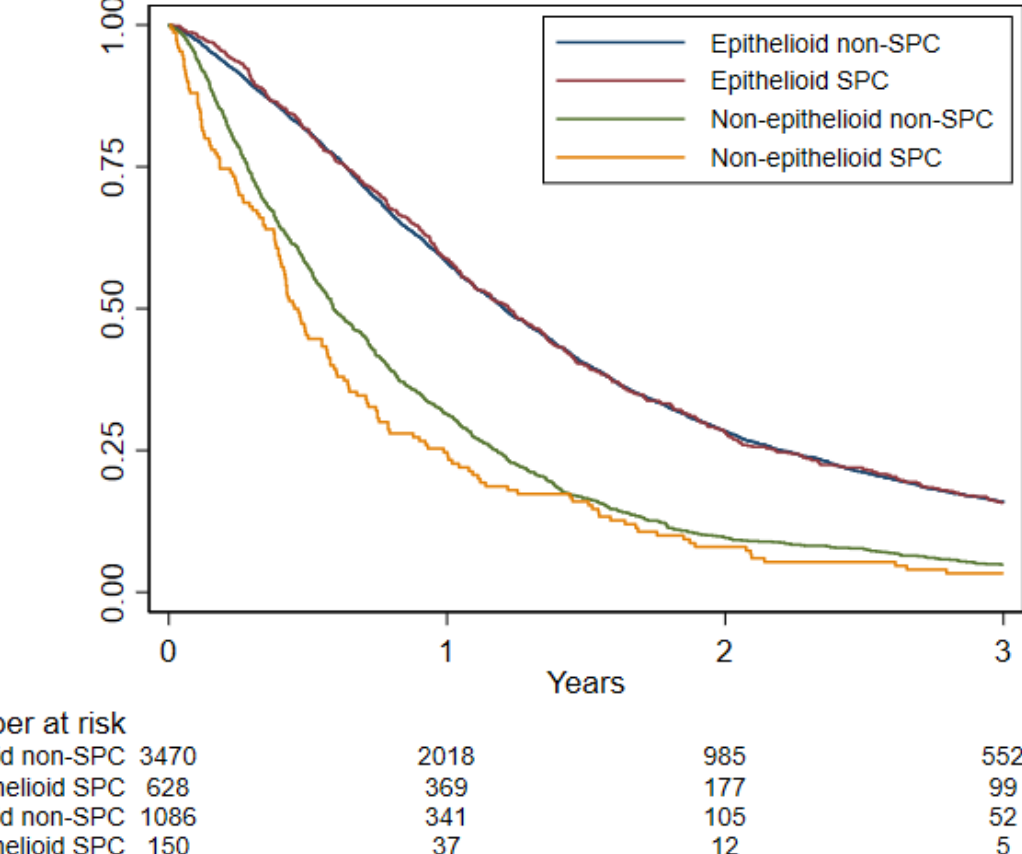
Figure 4. Overall survival among non-SPC and SPC for epithelioid and non-epithelioid histotypes estimated using Kaplan–Meier curve, Lombardy, 2000–2018. Follow-up period 2000–2021. Table 5. Overall survival by second primary cancers (SPC), histotype, and by SPC/histotype jointly, Lombardy 2000–2018. Follow-up period 2000–2021.